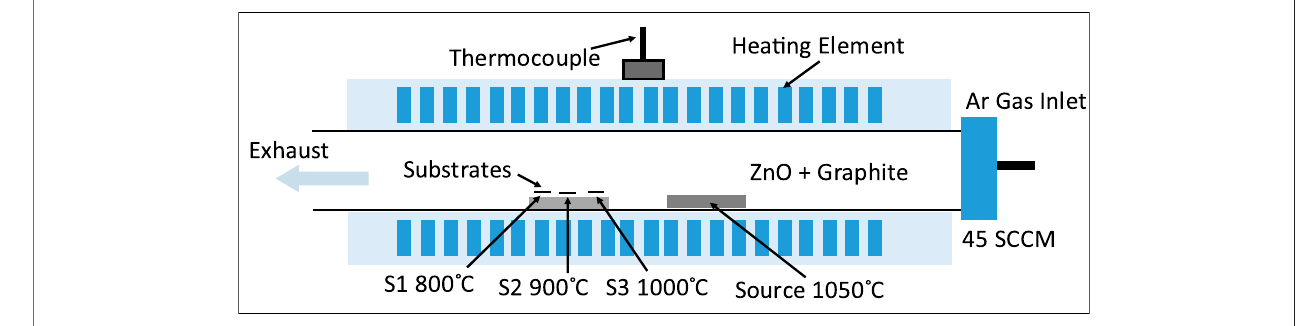
FIGURE 1 | Schematic diagram of the experimental setup of the VLS method.